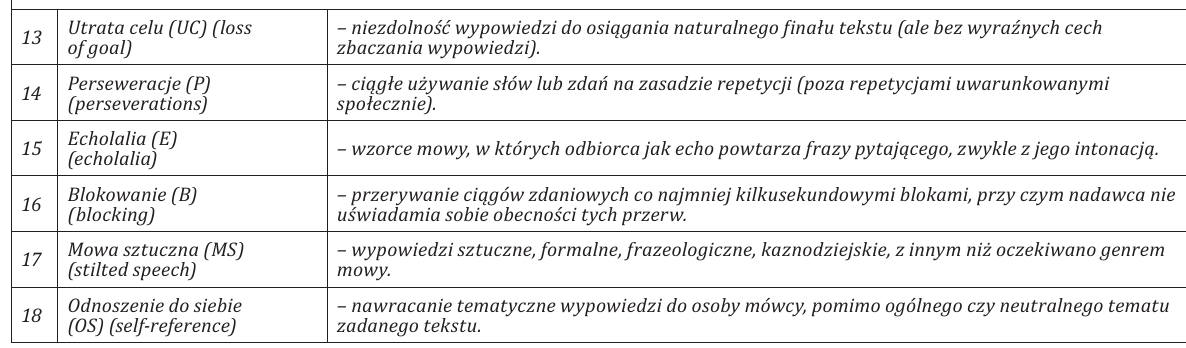
1. Korpus tekstu uzyskany od dwóch pacjentów chorujących na schizofrenię z wysokim poziomem schizofazji. studentów logopedii, w czasie zająć akademickich